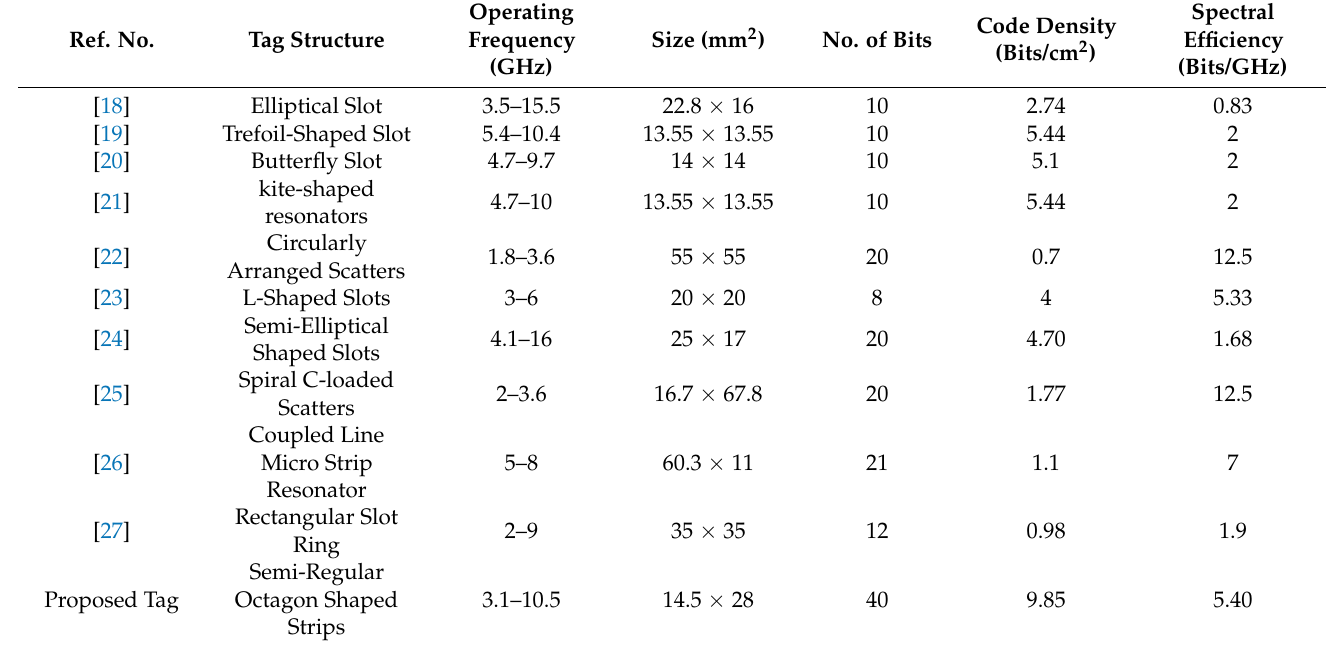
Table 4. Comparison with state-of-the-art CRFID